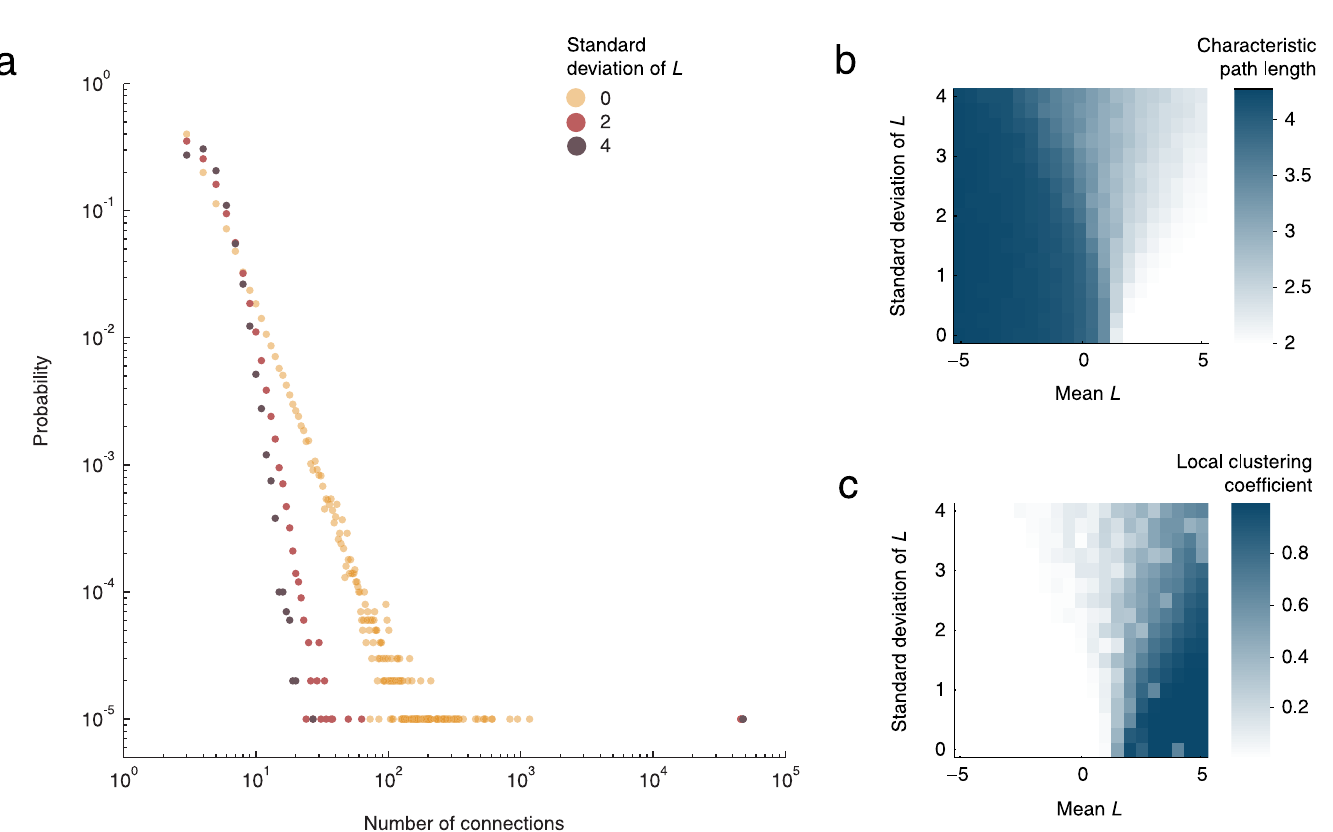
Fig 4. The structure and connectivity of a growing network depends on the policy used by a newcomer when selecting its connections. (a) The degree distribution specifies how likely it is for a person to have a particular number of connections. These are the degree distributions for three networks that vary only in the standard deviation of L across the population (10,000 individuals, L = 1, m = 3). Introducing individual differences bends the degree distribution away from being a straight line, the signature of a scale-free network. (b) Another measure of network connectivity that is affected by the variability is the characteristic path length — the average distance between individuals. Notice the interaction between the direction of the effect and the value of L with no effect of individual differences at L = 1. (c) A third affected measure of network connectivity is the local clustering coefficient, the proportion of possible connections among one ’ s friends that actually exist, averaged across all people. We tested mean values of L between – 5 and 5 in steps of 0.25, and standard deviations of L between 1 and 4 in steps of 0.25. Each combination of parameter values was run once, with m = 3 and 10,000 nodes.